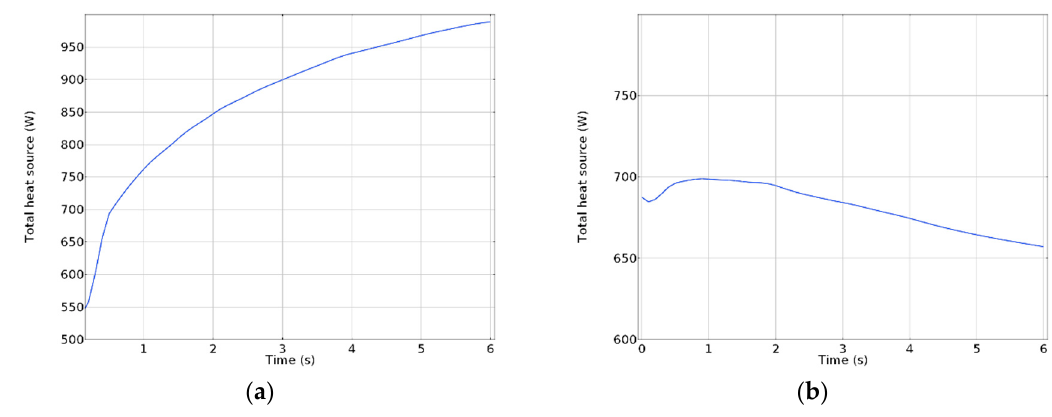
Figure 8. Heating power—brazing assembly, ( a ) copper, ( b ) stainless steel.